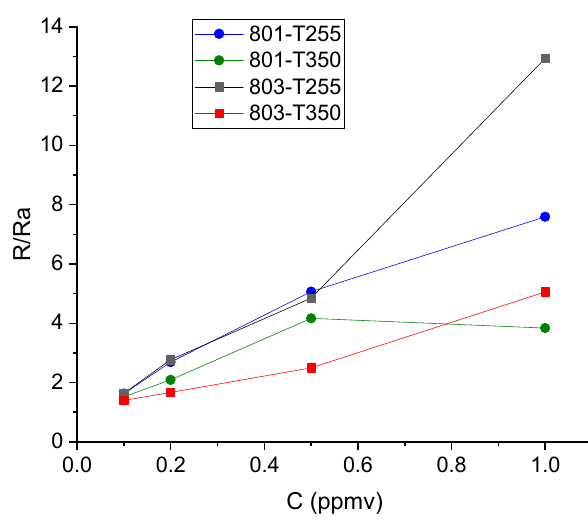
Figure 8. Response of the commercial sensors to low NO 2 concentrations at two operating temperatures. Table 3. Errors of the different calibrations for the commercial sensors.